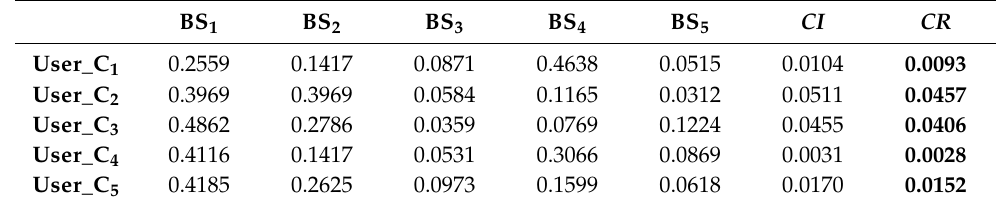
Table A18. The hierarchical single sorting results of User _ C i . The CR of each matrix is in bold.